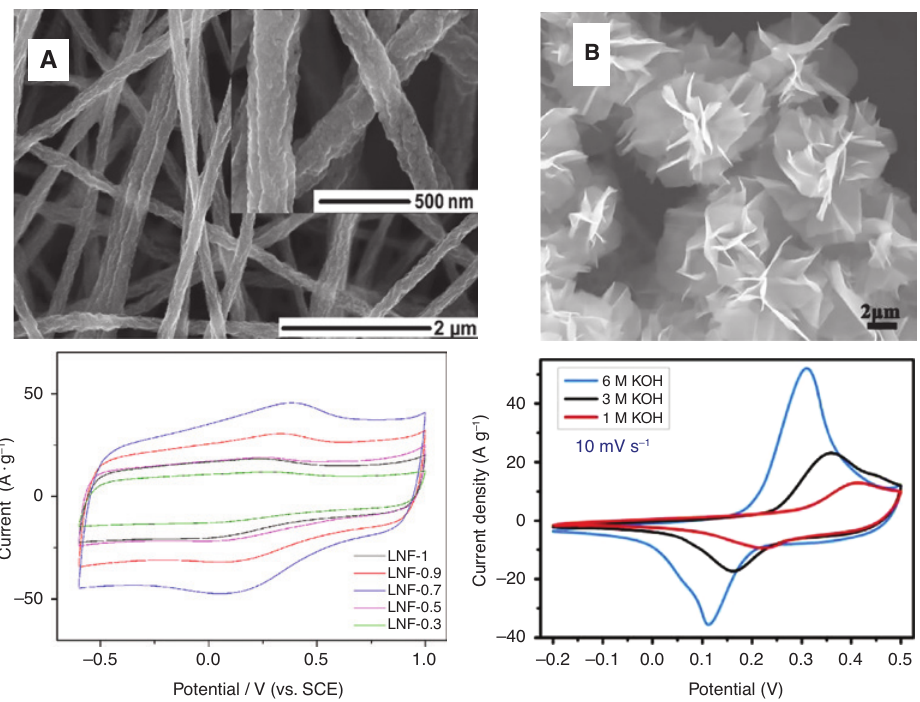
Sr CoO nanofibers, (B) La 0.7 0.3 3- δ